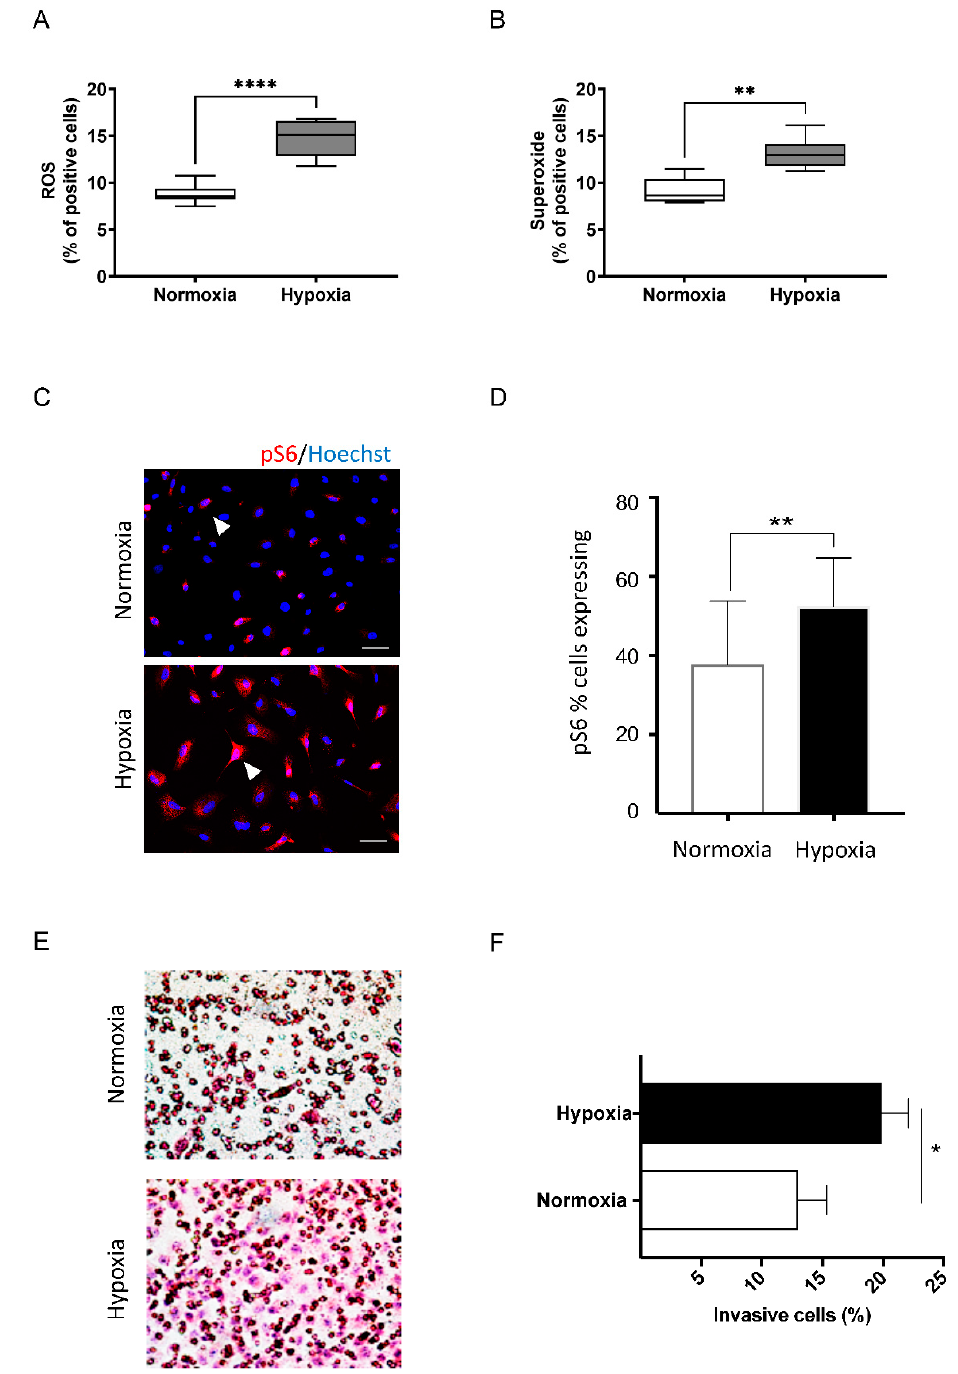
Figure 3. Cells in the deoxidizing absorbers chamber displayed increased levels of ROS, Superoxide, mTOR levels, and invasive capacity. Cells cultivated in the presence of deoxidizing display ( A ) increased ROS and ( B ) superoxide levels (**** p < 0.00001, ** p < 0.001, respectively). ( C ) Im- munofluorescence demonstrates increased expression levels of the mTOR readout marker pS6 in cells cultured under hypoxia (scale bar 50 µ m). ( D ) Quantification of positive cells for pS6 shows a statisti- cally significant activation of mTOR signaling under hypoxia compared to the control (normoxia) (** p < 0.001). ( E ) Invasion assay using Millicell cell culture inserts during normoxia and hypoxia, demonstrating the enhanced invasive capacity of tumor cells cultured under hypoxic conditions. ( F ) Quantification of invading cells, demonstrating a statistically significant increase in invasive behav- ior in tumor cells under hypoxia (* p < 0.05).